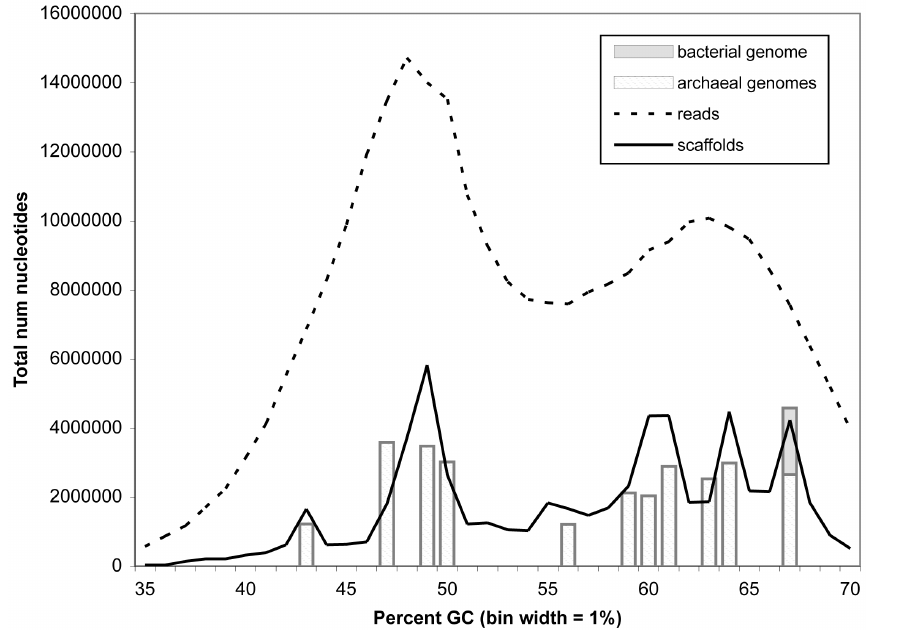
Figure 1. Length-weighted %G + C nucleotide composition of unassembled reads, assembled scaffolds, and composite population genomes. Genomes were constructed by targeted assembly of scaffolds with a uniform signature of phylogenetic binning properties, as described in Materials and Methods. Genome names, percent G + C, and other general properties of assembled genomes are shown in Table 1. doi:10.1371/journal.pone.0061692.g001 confirmed by adjacency in a maximum-likelihood phylogenetic tree (Figure 2). Mean assembly depths of coverage for both J07HQW1 and J07HQW2 (8.8-fold) were more than three-fold higher than for J07HQX50 (2.5-fold), suggesting considerably greater environmen- tal abundance (Figure S4).